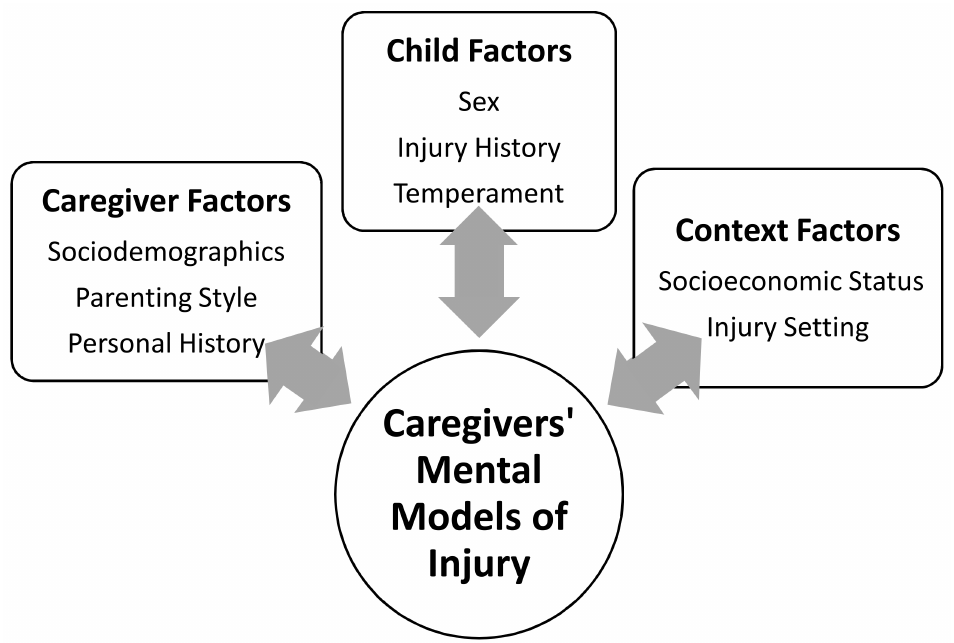
Figure 1. Examples of factors that may influence caregivers’ mental models of